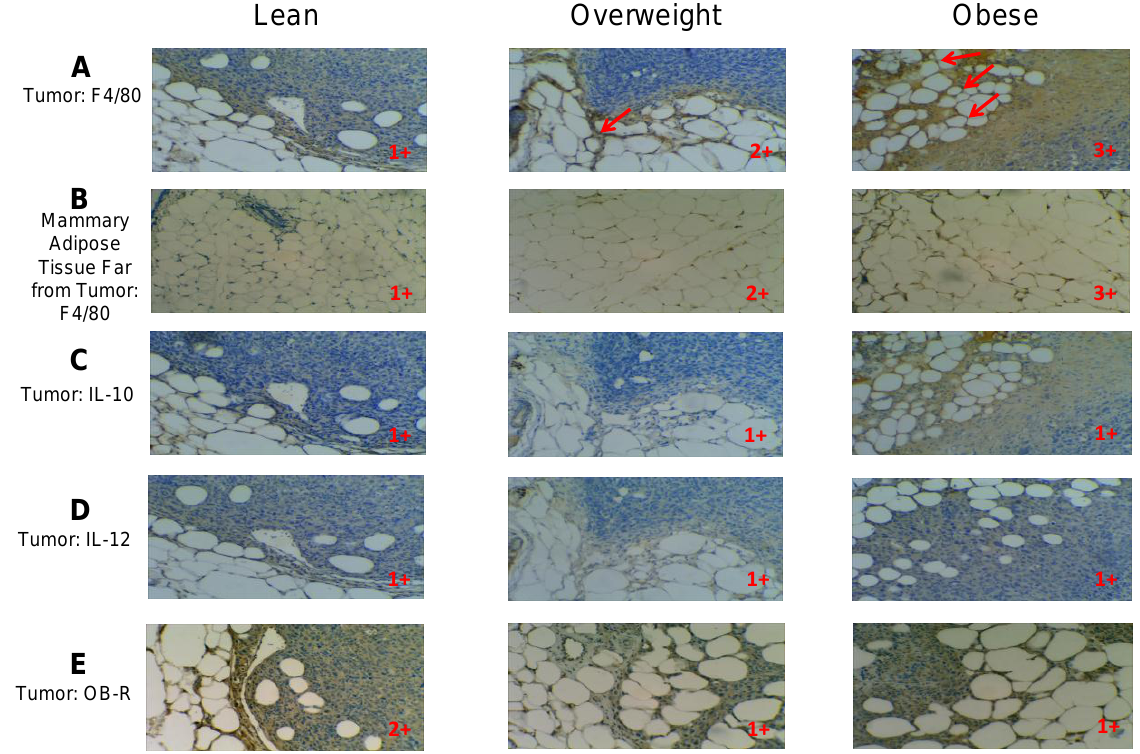
Figure 10. Mammary adipose tissue is inflammatory in obese mammary tumor-bearing females: comparison of mammary fat in the tumor microenvironment vs . mammary fat distant from the tumor. IHC was performed in sections of mammary tumors and in tumor-distal mammary adipose tissues of obese, overweight and lean C57 BL6 tumor bearer female mice. IHC- positive cells appear in brown (20× magnification in all the slides). ( A